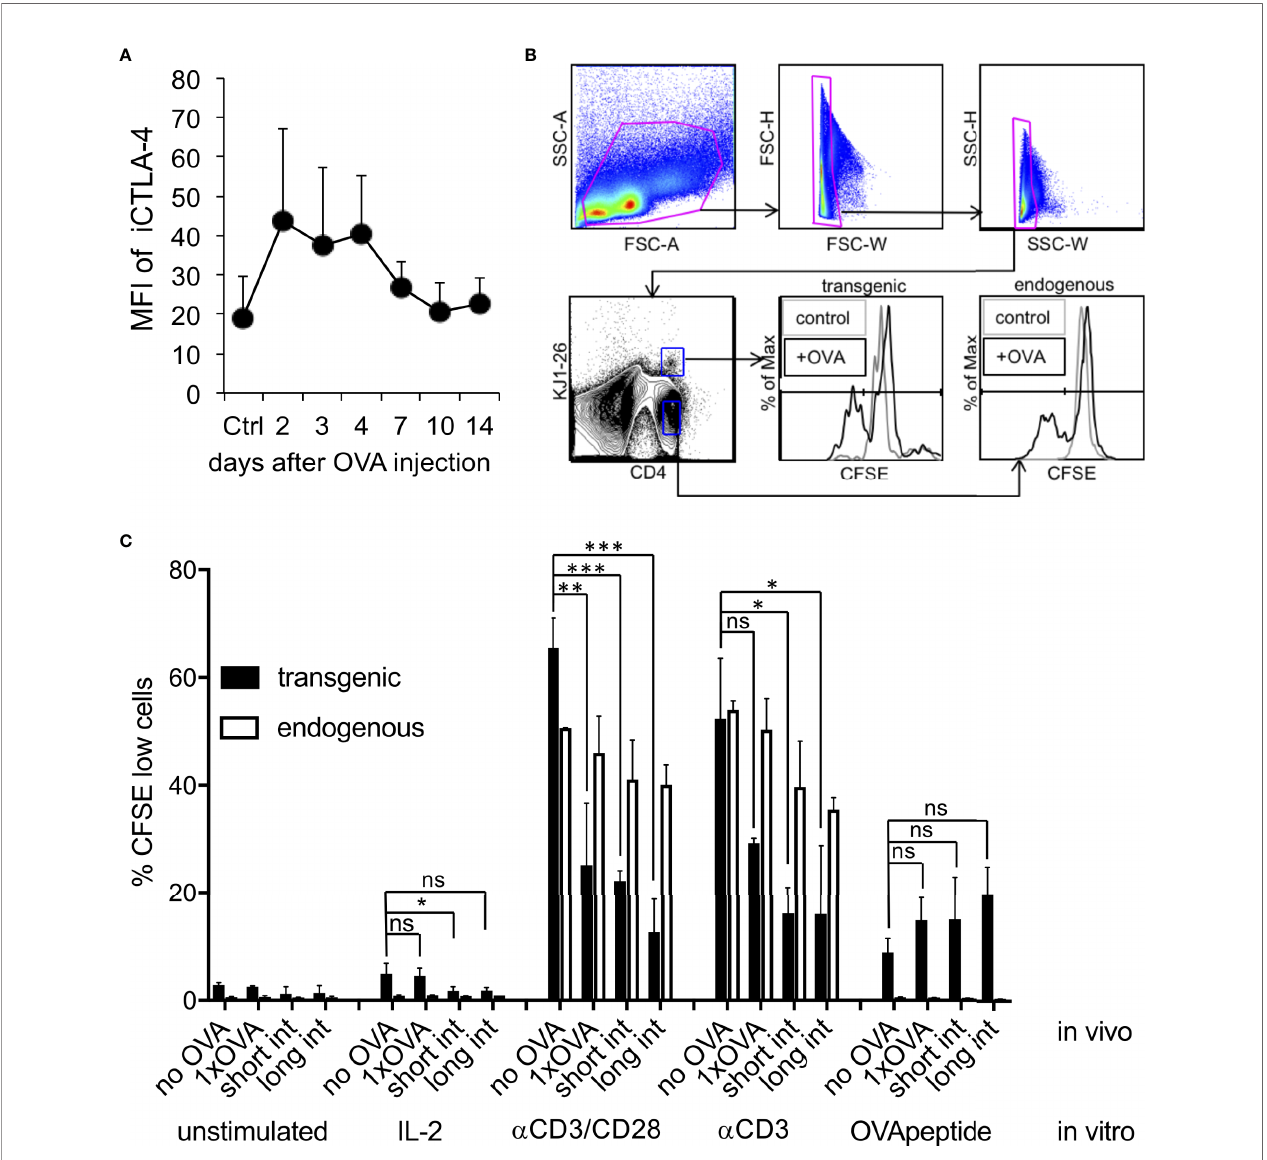
FIGURE 5 | Induction of intracellular CTLA-4 and CD4+ T cell anergy in vivo. DO.11.10 T cells (1x10 7 ) injected i.v. into BALB/c mice and one day later with a high dose endotoxin-free OVA protein. (A) . FACS analysis of CD4 + , KJ1-26 + , Foxp3 - cells for their iCTLA-4 mean fl uorescence intensity (MFI) of spleen cells was performed at the indicated time points. Control mice received DO11.10 cells but remained without OVA injection (Ctrl). MFI = mean fl uorescence intensity (n=3 mice, Error bars: SD). (B) . Gating strategy for results shown in (C) . Some animals were injected a second time with OVA using the same dose and route after 3 days (short interval) or 11 days (long interval). Seven days after the last OVA injection spleen cells were labelled with CFSE and restimulated ex vivo as indicated. FACS analysis for CD4, KJ1-26 and CFSE of spleen cells was performed to analyse the proliferation history of the DO11.10 T cells. Control mice remained without OVA injection (no OVA). Error bars: SD. Statistics only for transgenic T cells with one-way ANOVA with Tukey ’ s test for multiple comparisons. *p < 0.05, **p < 0.01, ****p < 0.0001. ns, not signi fi